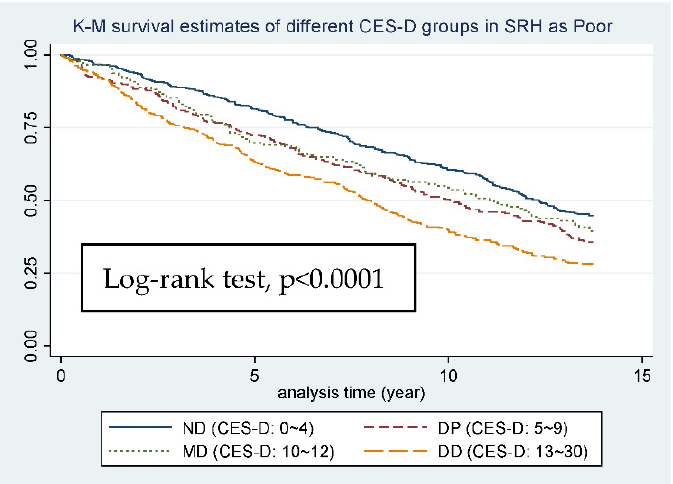
Figure 5. K-M survival estimates of different CES-D groups in SRH as Poor.